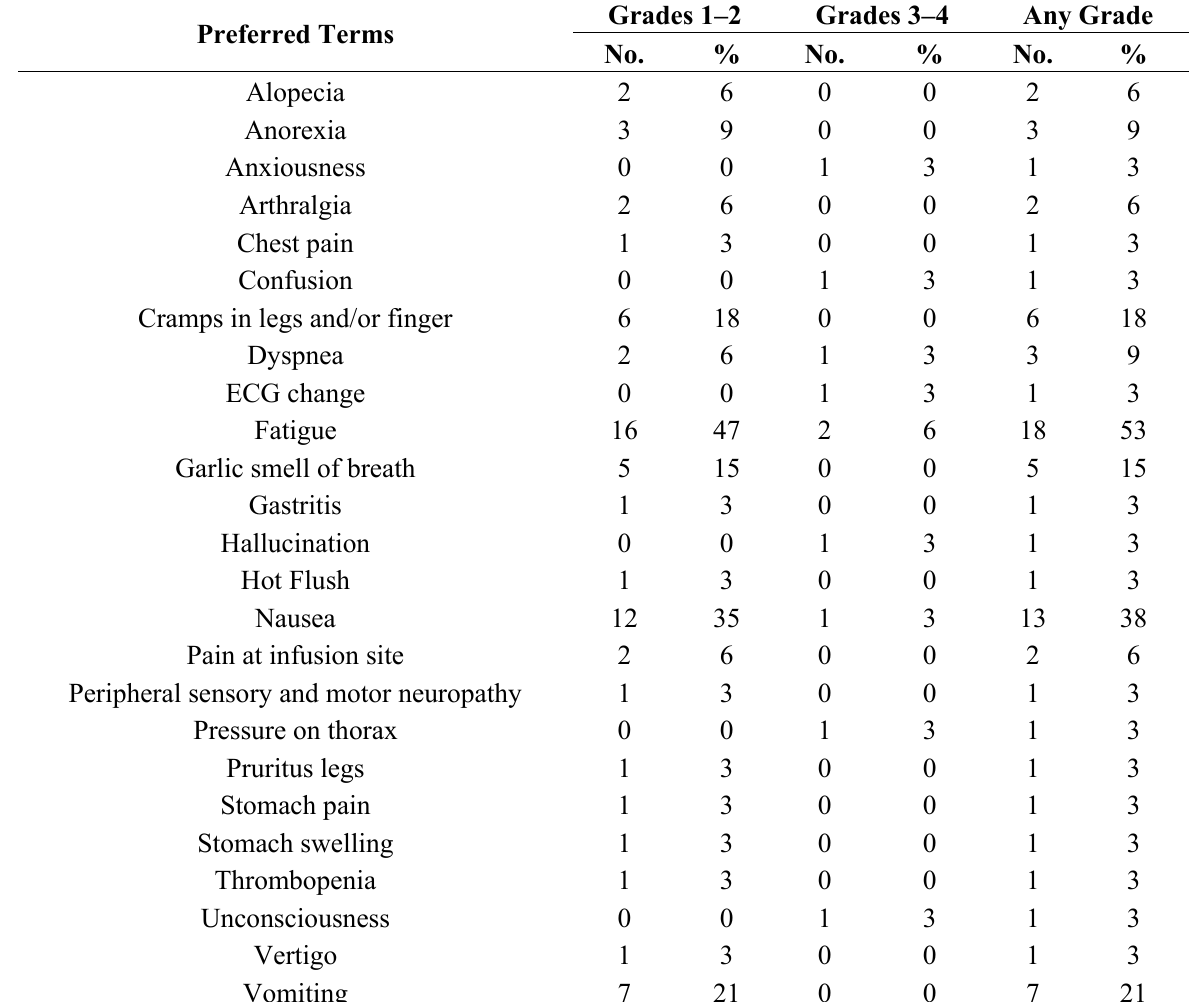
Table 3. Treatment-Emergent Clinically Significant Adverse Events (AEs) by Preferred Terms.